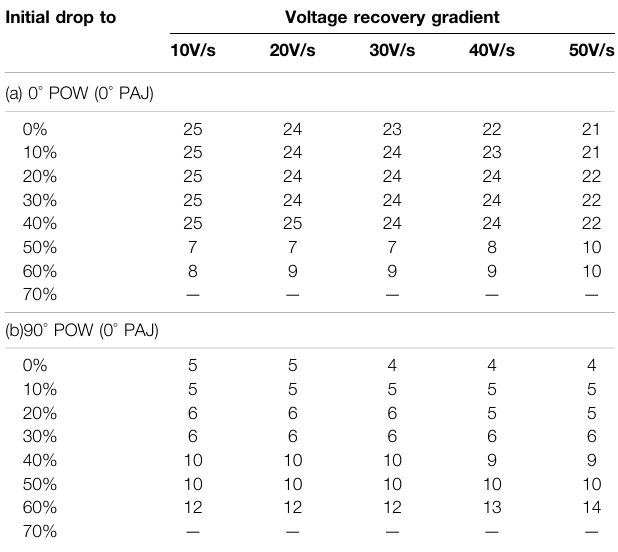
TABLE 4| Duration (ms)oftheslowrecoveryvoltagesagtodisengageforR4asa function of initial voltage drop and the voltage recovery gradient. Initial drop